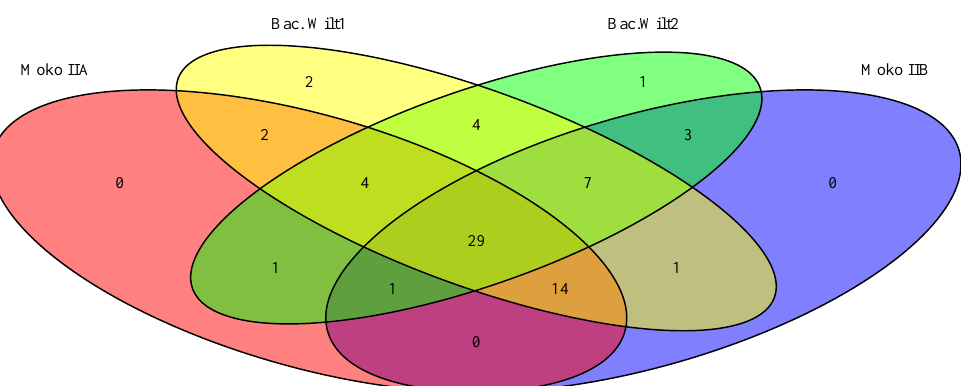
Figure 11. Rips shared among newly sequenced isolates (Moko IIA, Moko IIB, and BW1) plus public Brazilian BW isolates, RS488 and RS489